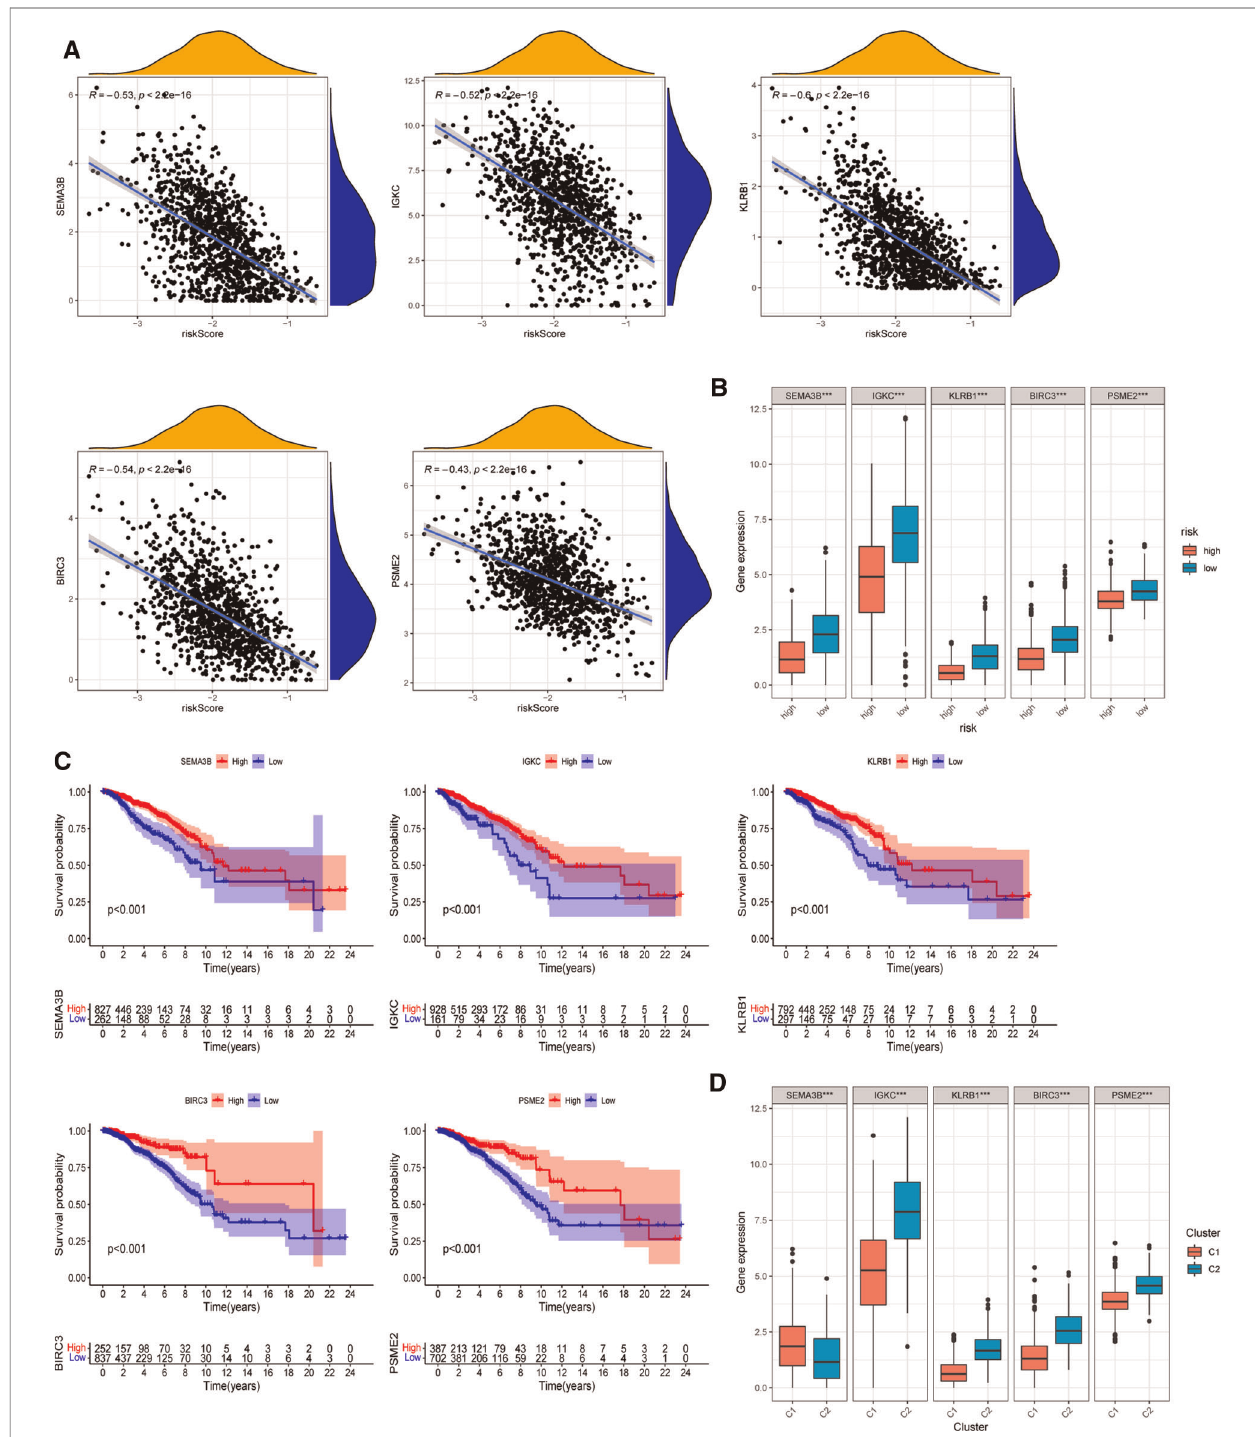
FIGURE 8 | Roles of selected fi ve genes in risk signature and BC prognosis. ( A ) Correlations between risk signature and SEMA3B, IGKC, KLRB1, BIRC3, and PSME2. ( B ) Expression of the fi ve genes in two risk subgroups. ( C ) Kaplan – Meier curves of SEMA3B, IGKC, KLRB1, BIRC3, and PSME2 in the TCGA-BRCA cohort. ( D ) Expression levels of the selected fi ve genes in two PR clusters. * p <0.05, ** p <0.01, *** p <0.001, ns, not signi fi